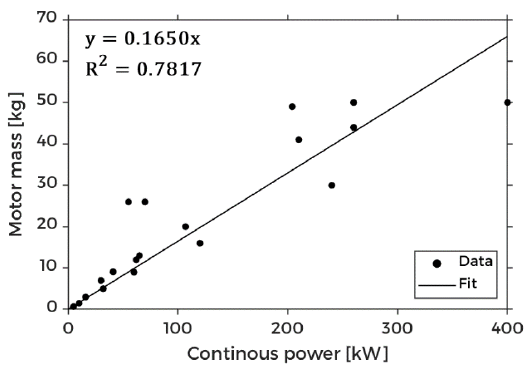
Figure 5. Electric motor power density regression model.